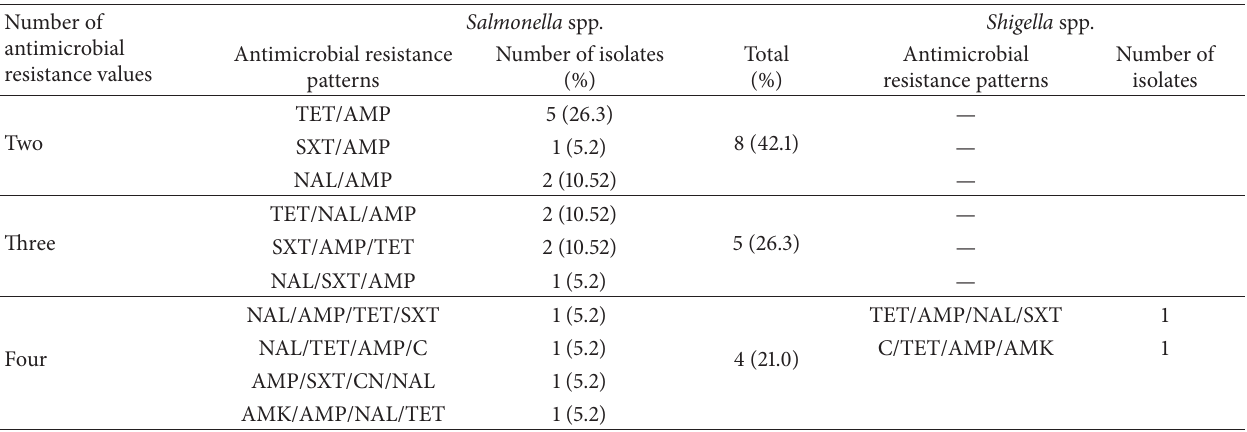
Table 4: MDR of Salmonella spp. and Shigella spp. isolated from diarrheal outpatients in Jimma University Specialized Hospital, Jan–Mar, 2014.